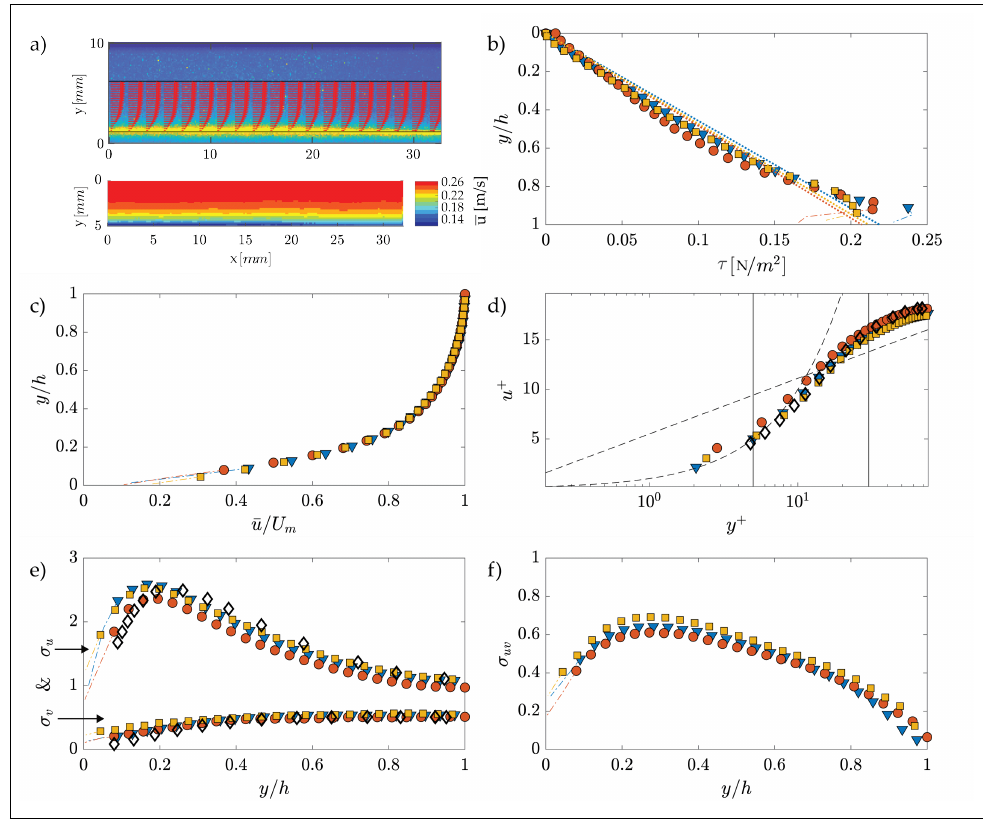
Figure 3. Velocity statistics obtained from PIV measurements in the lower half of the test section for three different streamwise positions; h is the channel semi-height, u + = u / u* is the normalized veloc- (cid:112) ity; y + = y u*/ ν is the normalized distance from the wall, U m is the maximum speed, σ v = v (cid:48) 2 /u* (cid:112) and σ u = u (cid:48) 2 /u* are the non-dimensional root squares of the variance for wall-normal and longitu- √ dinal velocity fluctuations, respectively, and σ uv = v (cid:48) u (cid:48) /u* is the non-dimensional root square of the covariance. ( a ) Flow field and contour plot for test F-1; ( b ) total shear stress for all tests; ( c ) non- dimensional mean-velocity profiles (outer scaling); ( d ) non-dimensional mean-velocity profiles (inner scaling), the dashed line represent the linear law u + = y + , characterizing wall flows for y + (cid:46) 5 (see e.g., Pope (2000) [30]); ( e , f ) non-dimensional profiles of velocity variances. Symbols and experimental conditions for all the tests are reported in Table 1, with the exception for ♦ that refers to the data from the DNS by Tsukara